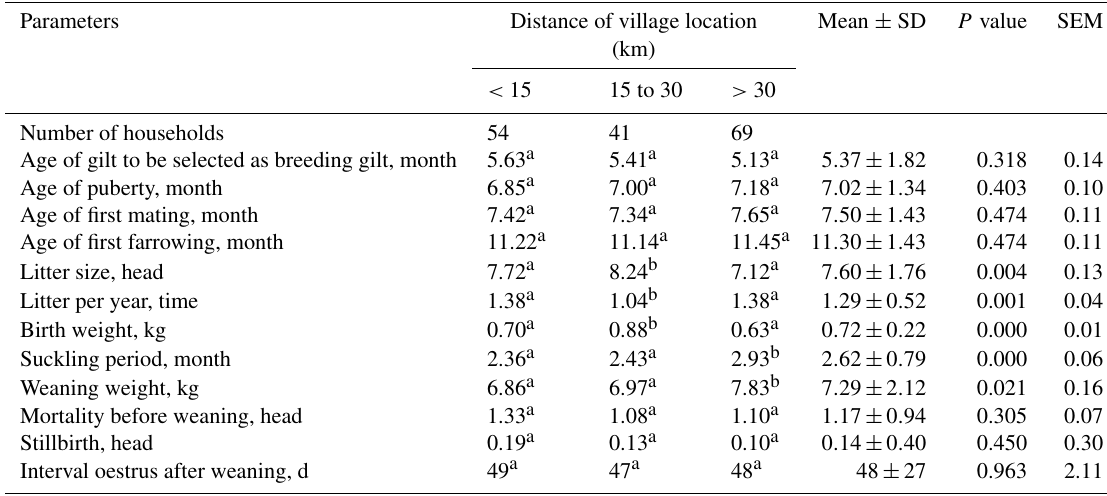
Table 2. Comparison on reproductive performance of indigenous pigs based on village locations. Parameters